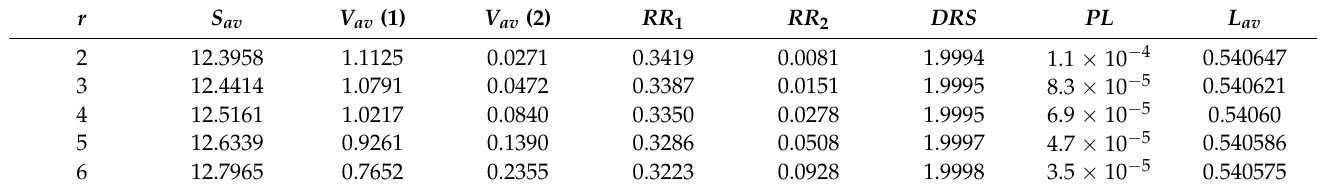
Table 9. Dependence of the performance measures on parameter r ; λ = 2, µ 1 = 5, µ 2 = 6, κ = 2, ν 1 = 3, ν 2 = 5, τ = 2, s = 8, S =